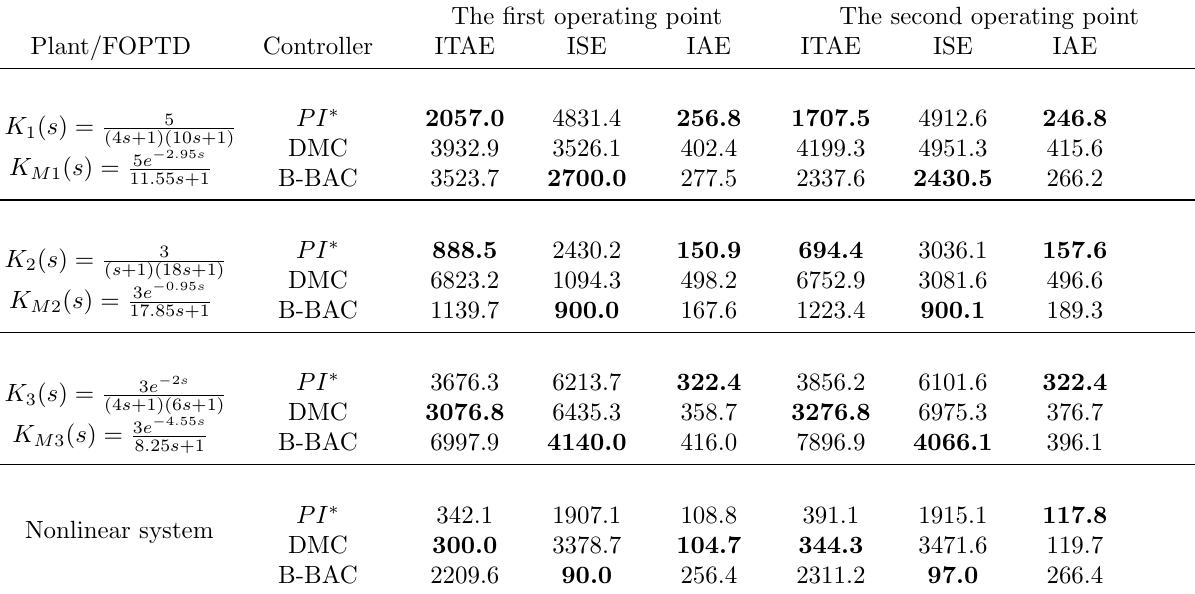
Table 1: Performance index values for two different operating points of the plant.